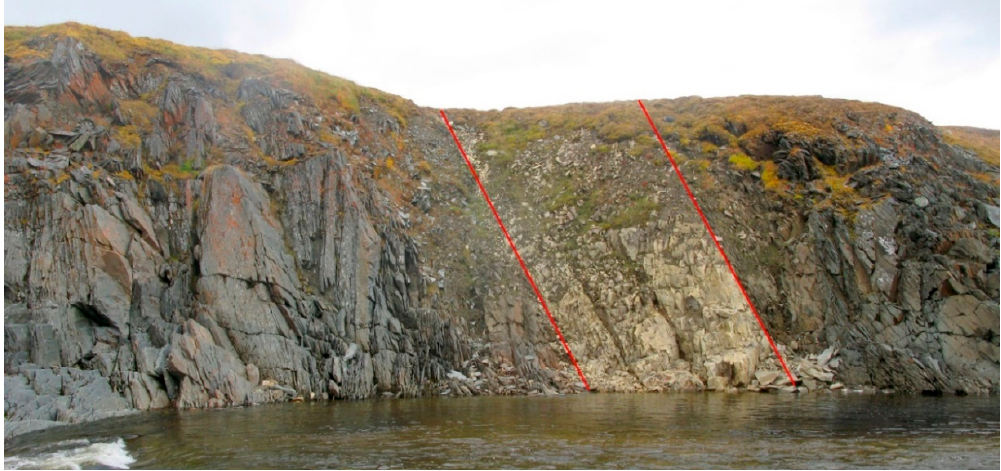
Figure 8. Field photograph of the dike of quartz porphyry (within red lines) cutting thinly interlayering metamorphosed siltstones and sandstones, sample 203025, Spokoynaya R., location on Figure 3.